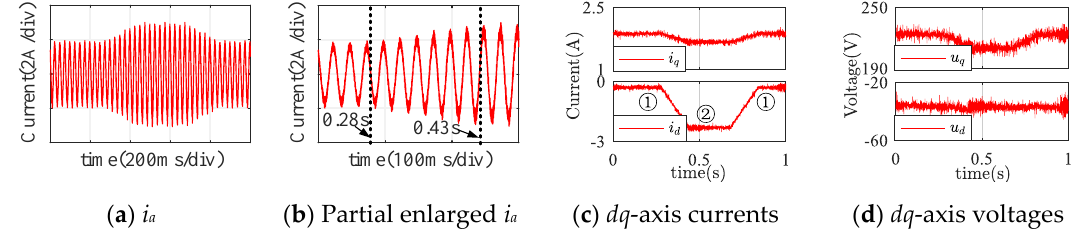
Figure 8. Currents and voltages of the parameter identification method.